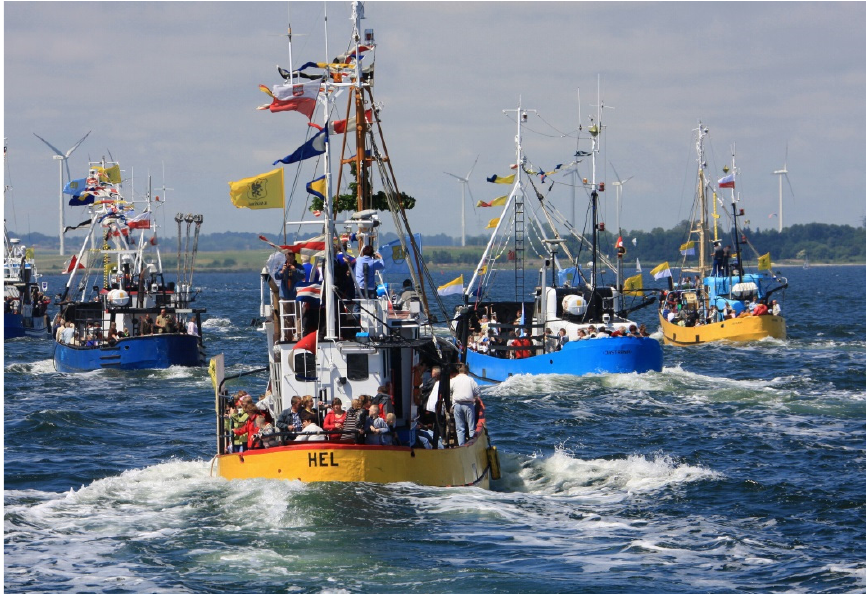
Figure 2. Typical fishing boats participating in the sea pilgrimage. Author: (Tadeusz Palmowski 2009).